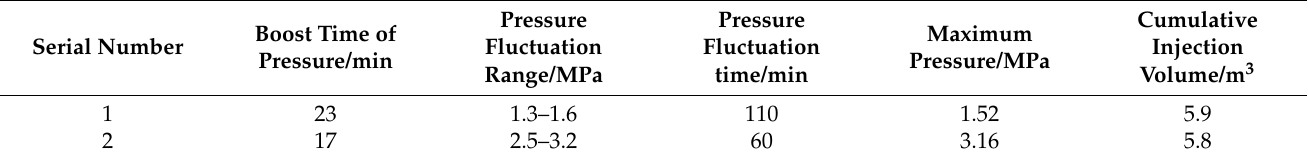
Figure 6. The sealing lengths of injection hole and inspection hole ( a ) The sealing length of injec- tion hole and ( b ) The sealing length of inspection hole.